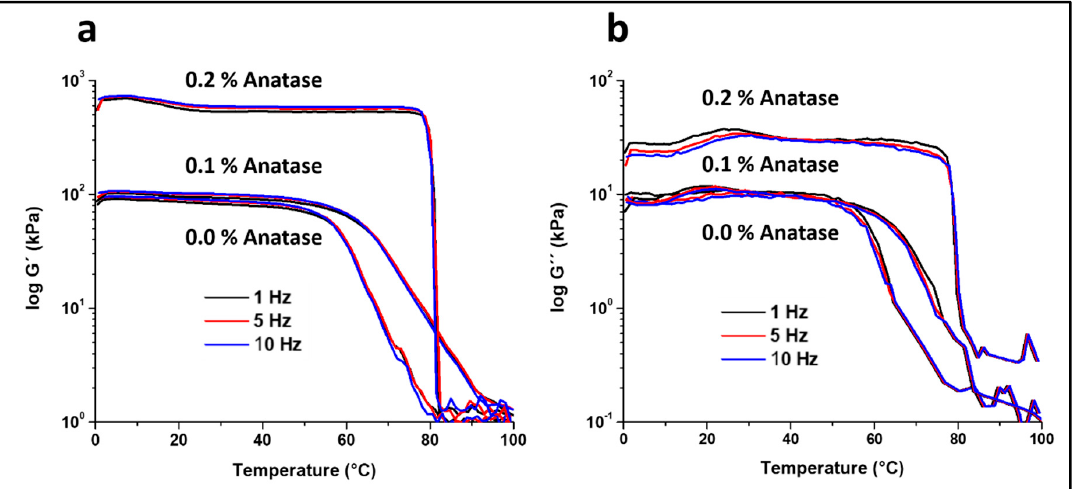
Figure 2. Results of the dynamic mechanical analysis (DMA) at 1, 5, and 10 Hz. ( a ) Elastic modulus (G’). ( b ) Loss modulus (G’’).